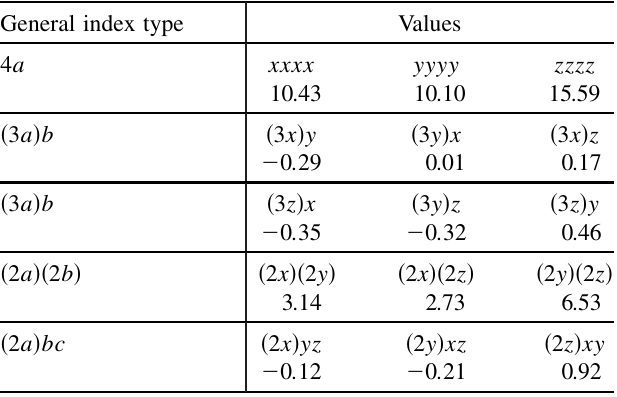
TABLE III. Elements of (cid:1) DMPC in units of 10 (cid:1) 50 m 5 V (cid:1) 2 . General index